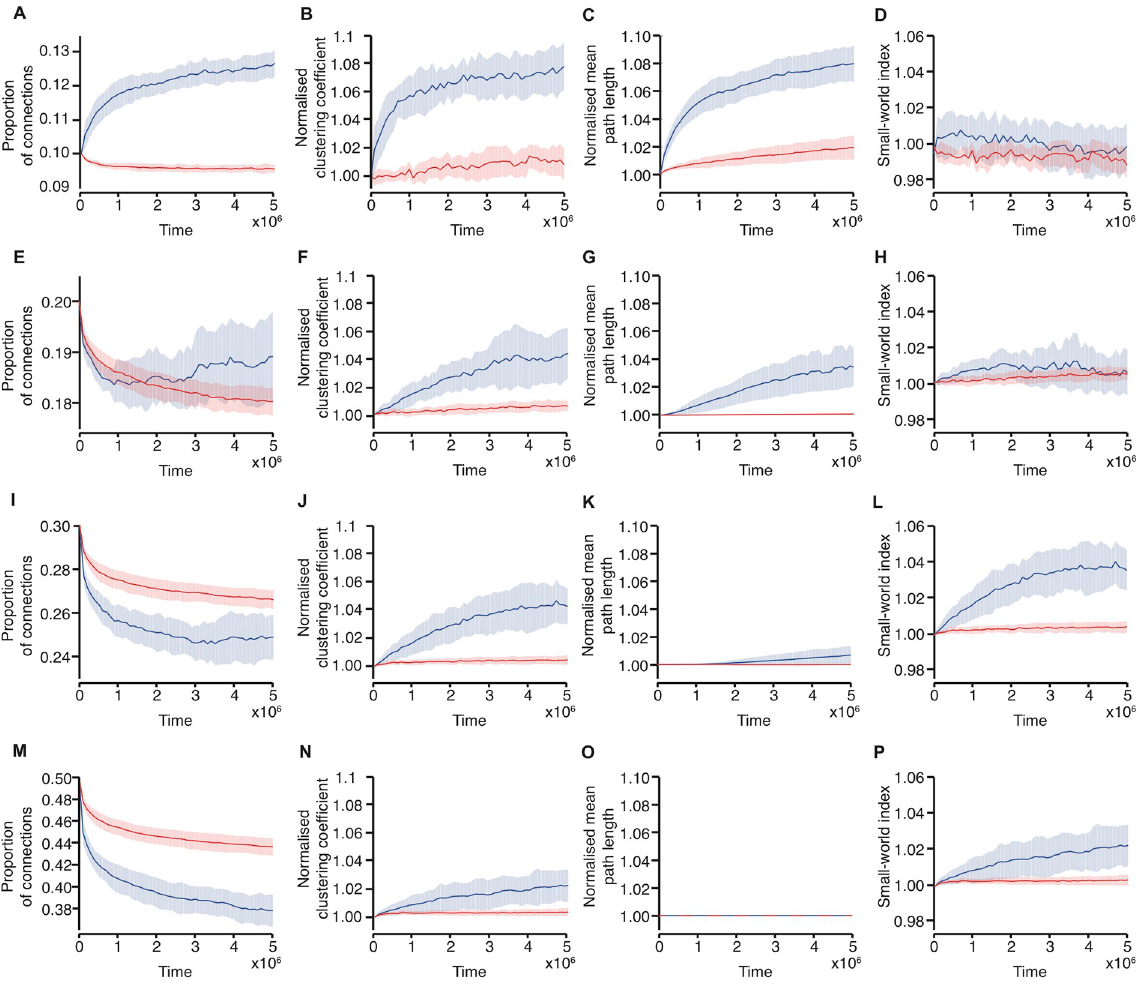
Fig 5. Changes in connectivity in relation to the initial network density. (A,E,I,M) The proportion of connections in the network, (B,F,J,N) normalised clustering coefficient, (C,G,K,O) normalised mean path length and (D,H,L,P) small-world index across the course of 20 simulations with an initial network density of (A-D) 10%, (E-H) 20%, (I-L) 30%, and (M-P) 50%. The networks are driven with burst dynamics which exhibit LRTCs ( H � 0.7, blue), compared with the same input randomly shuffled in time (red). Solid lines indicate the mean across the 20 simulations and the shaded area indicates the standard